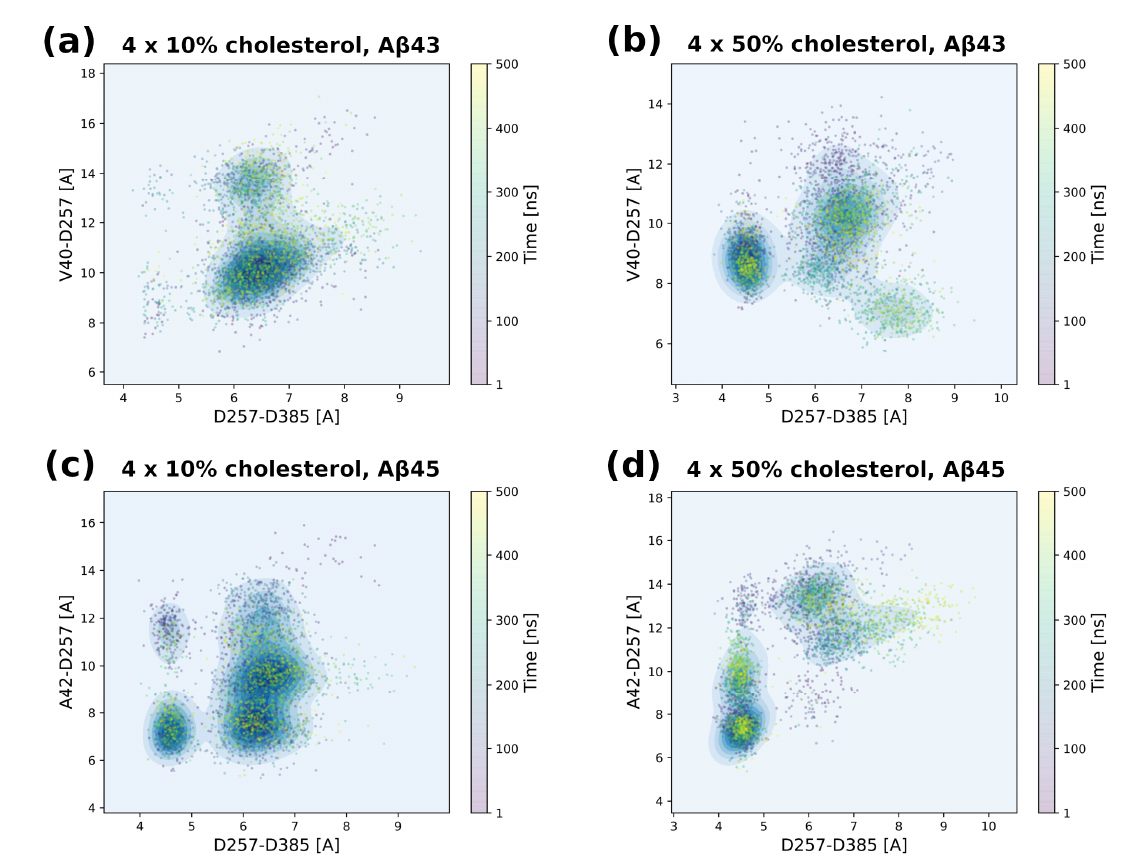
Figure 13. 2D scatter plots showing distances between catalytic residues (horizontal axes) and distances between one of the catalytic residue (D257) and the peptide bond that is to be cleaved (vertical axes). Each panel is the average of four MD simulations. All simulations for each type of the system (Aβ 43 /Aβ 45 and high/low cholesterol) were added to the grouping frames at the same time of simulation. All points are colored by the time of MD simulation from purple (0 ns) to yellow (500 ns). ( a ) MD simulations of γ-secretase complex with Aβ 43 substrate in 10% cholesterol membrane; ( b ) the same in 50% cholesterol membrane; ( c ) MD simulations of γ-secretase complex with Aβ 45 substrate in 10% cholesterol membrane; ( d ) the same in 50% cholesterol membrane.